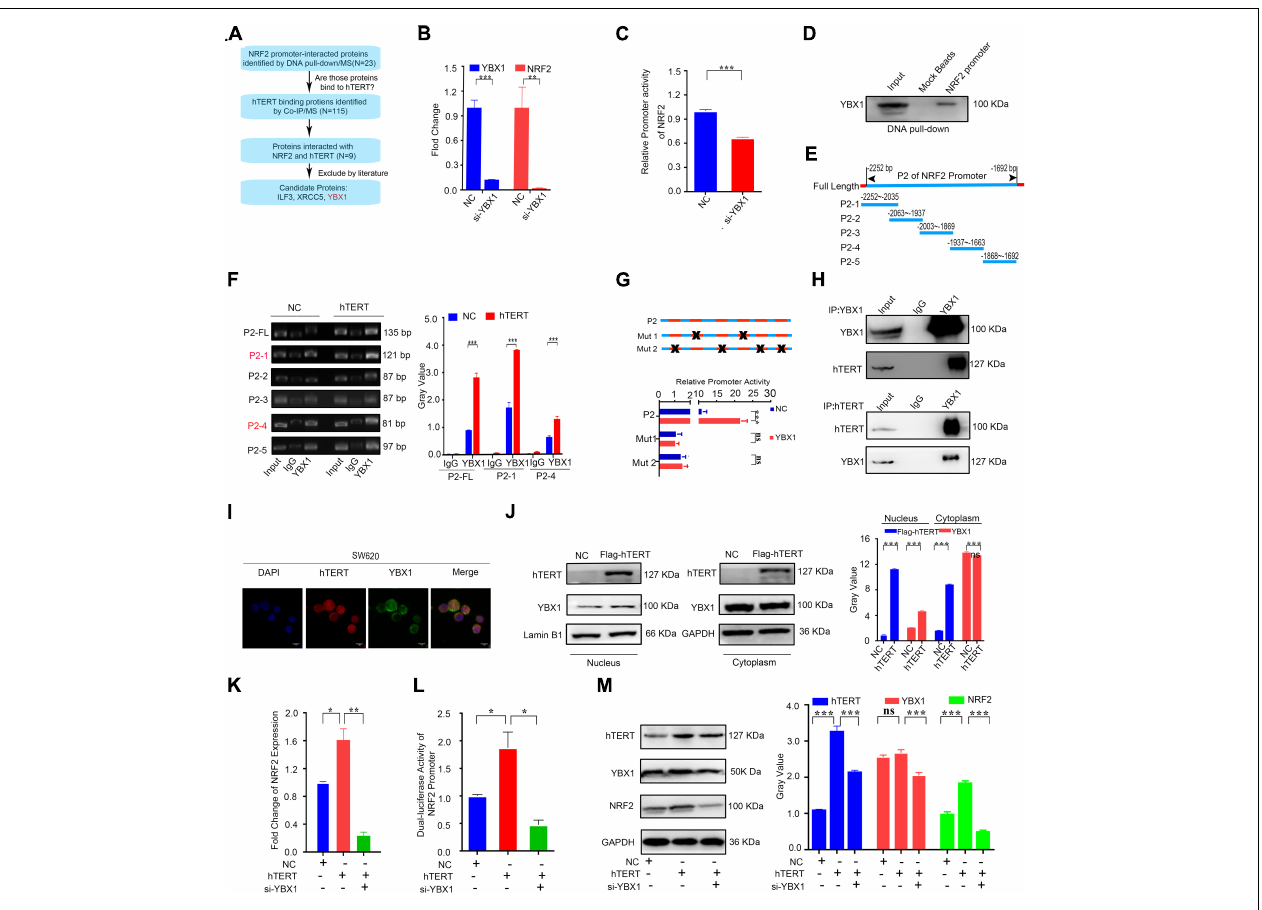
FIGURE 4 | Human telomerase reverse transcriptase (hTERT) increases NRF2 expression by recruiting YBX1 to bind to the NRF2 promoter. (A) Flow chart for screening of potential hTERT-recruited NRF2 transcription factors. (B) The YBX1 and NRF2 mRNA expression level was identified by qRT-PCR after downregulation of YBX1. (C) Luciferase activity of the NRF2 promoter was detected after downregulation of YBX1. (D) NRF2 promoter with a 5 (cid:48) biotin label was used to pull-down YBX1. Mock beads were used as a negative control. (E) Diagrammatic drawing of NRF2 P2 fragment. The P2 fragment was divided into 5 fragments. (F) YBX1 antibody was used to immunoprecipitate binding fragments of the NRF2 promoter under the condition of hTERT overexpression and fragments were identified by ChIP-qPCR with six primers (Left). Statistical analysis of ChIP-qPCR. (G) Luciferase activity of P2 fragment containing different mutant sites was detected after YBX1 overexpression. (H) HCT116 cell lysates were prepared for separate IP with hTERT and YBX1 antibody and then evaluated via western blotting. (I) The subcellular localization and the colocalization of hTERT and YBX1 were examined in SW620 cells via dual immunofluorescence using confocal microscopy. (J) YBX1 in cell nuclei and cytoplasm was identified by western blotting after overexpression of Flag-hTERT. (K) The NRF2 mRNA expression level was identified by qRT-PCR after overexpression of hTERT and simultaneous knockdown of YBX1. (L) Luciferase activity of the NRF2 promoter was detected after overexpression of hTERT and simultaneous knockdown of YBX1. (M) The NRF2 protein level was identified by western blotting after overexpression of hTERT and simultaneous knockdown of YBX1 (Left). Statistical analysis of western blotting (Right). * p < 0.05; ** p < 0.01; *** p < 0.001; ns, no